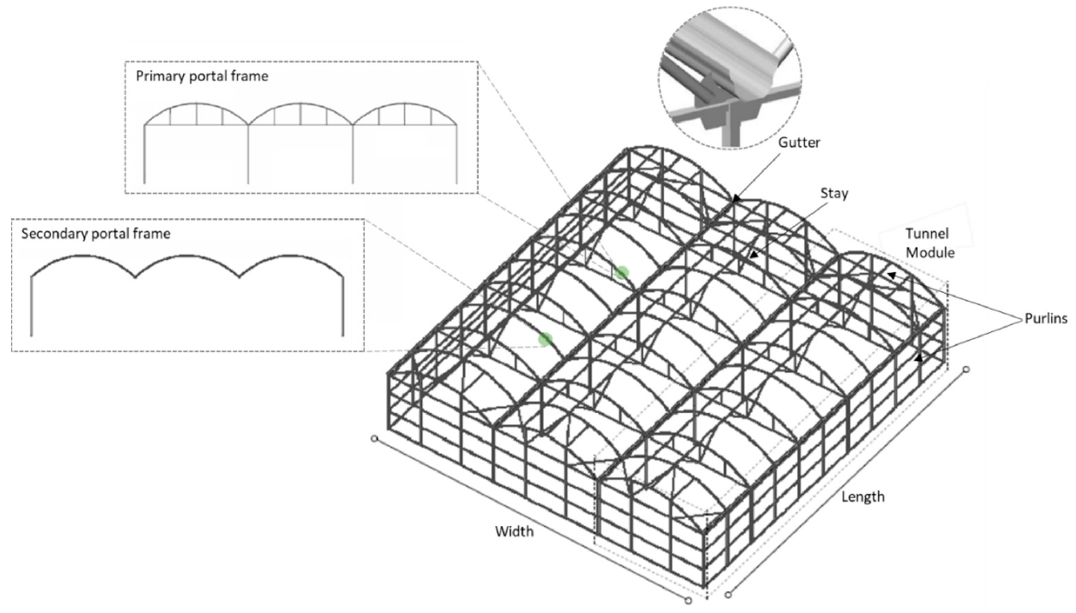
Figure 5. Typical greenhouse structure (adapted from Vázquez-Cabrera et al. [48] and Iribarne et al. [24]).